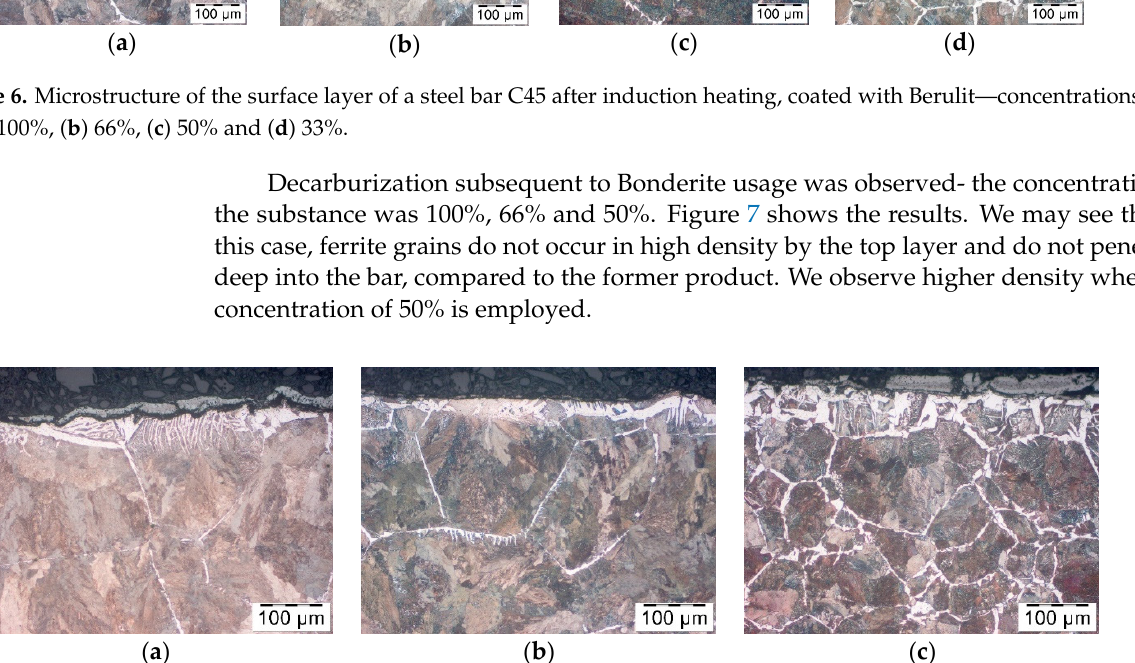
Figure 6. Microstructure of the surface layer of a steel bar C45 after induction heating, coated with Berulit—concentrations of ( a ) 100%, ( b ) 66%, ( c ) 50% and ( d ) 33%.